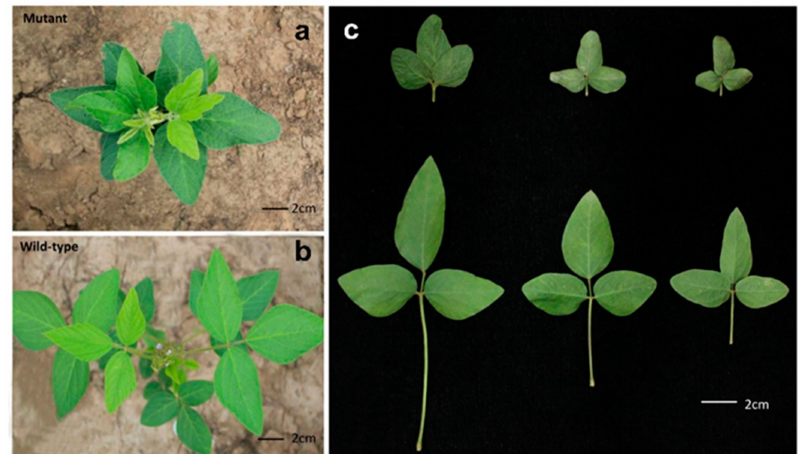
Figure 1. Canopy architecture and petiole morphology of the dsp mutant ( a – b ). Aerial view of the dsp mutant ( a ) and BW-2 wild-type plant ( b ). ( c ) The morphology and petiole length of wild type and mutant. Scale bars represent 2cm in all